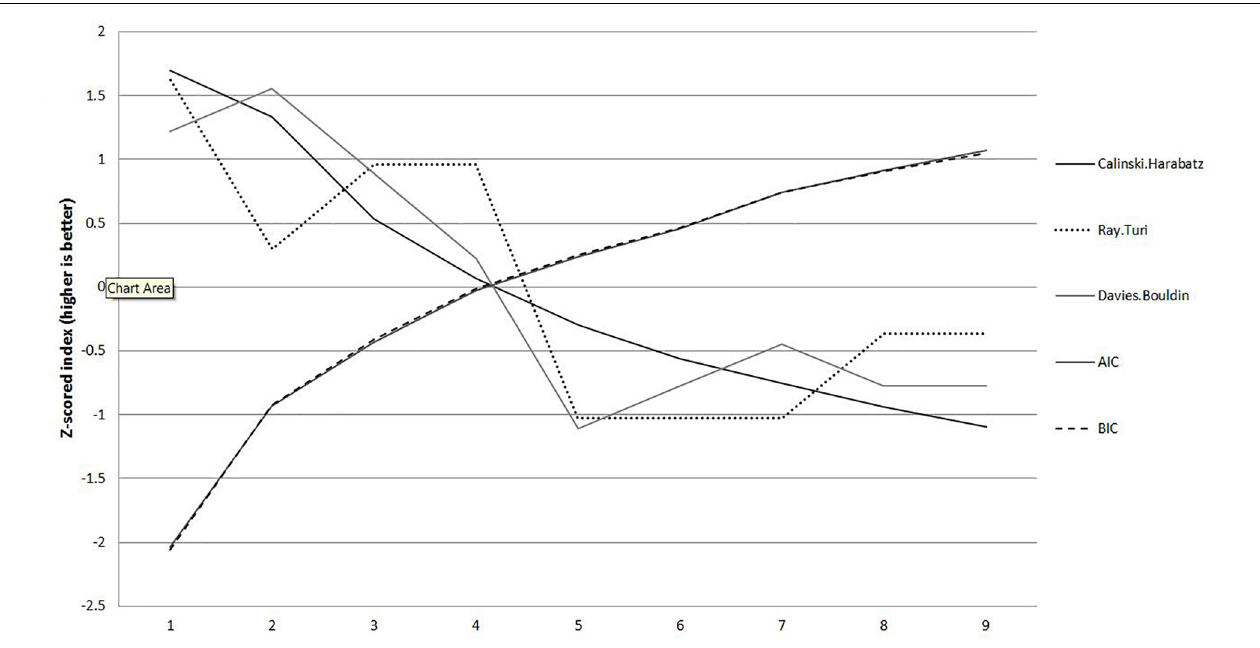
FIGURE 1 | Fit indices for different profile solutions. Horizontal bar indicates four profile cut-off.